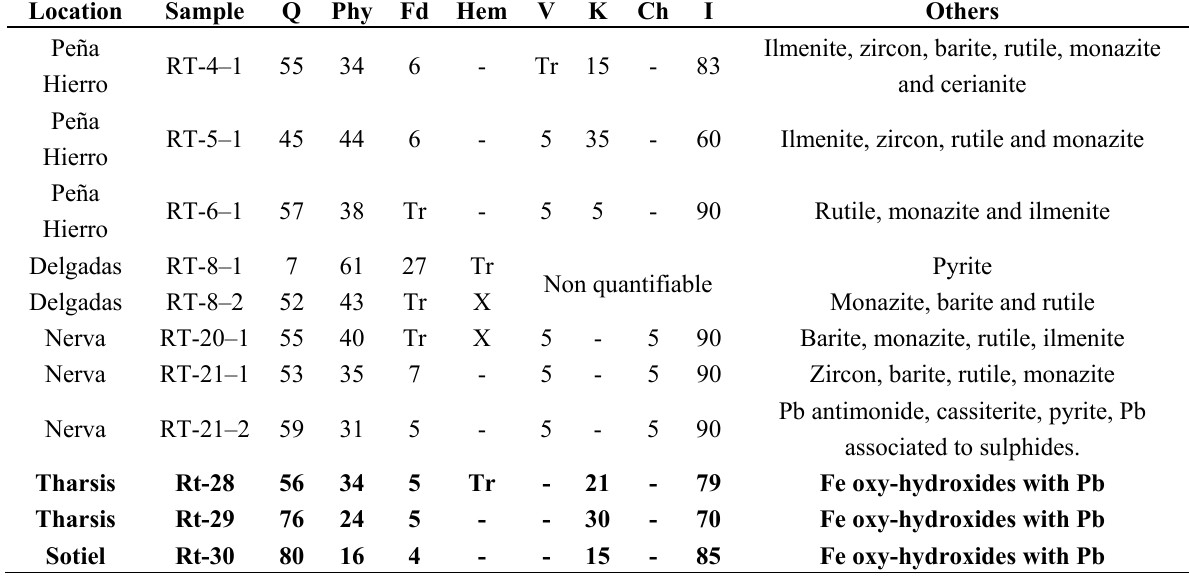
Table 10. Mineralogical composition of total and <2 µm fraction by XRD and SEM-EDS. Samples directly affected by waste rock piles or acid leachates are in